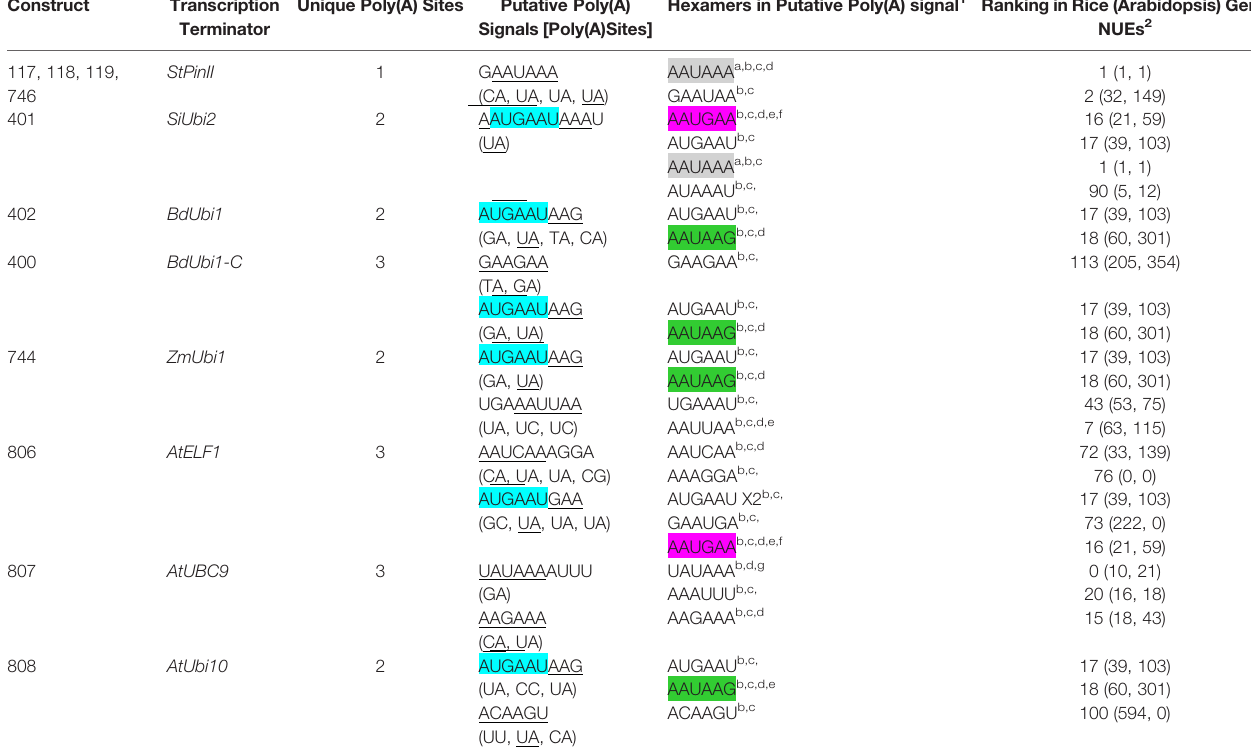
TABLE 1 | Analysis of putative poly(A) signals (PPSGs) in various transcription terminators (TTs).